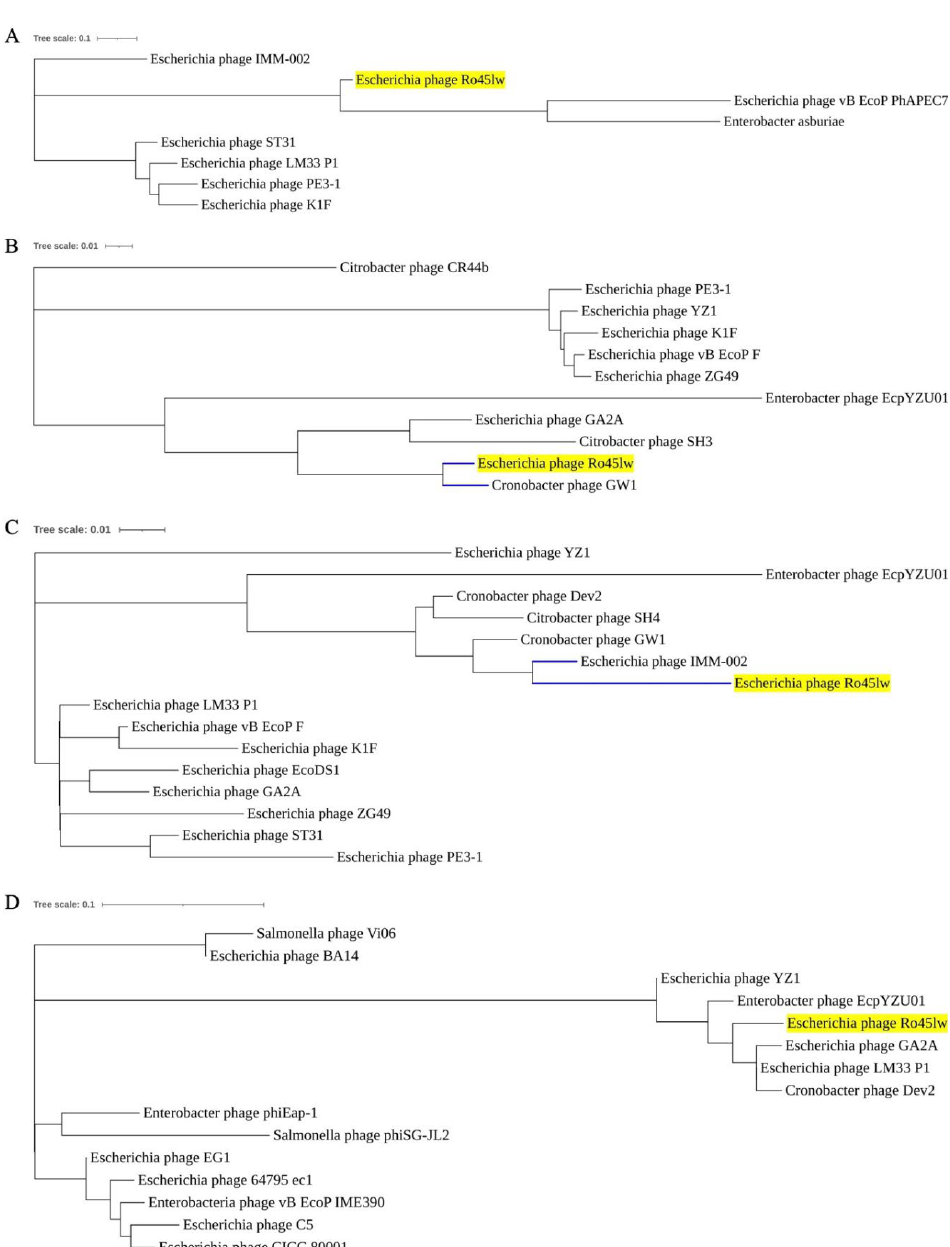
Figure 3. Phylogenetic tree of phage Ro45lw (with yellow highlight) and the close-related reference phages based on the Clustal Omega alignment of the amino acid sequences of putative tail fiber protein (ORF_44) ( A ), tail tubular protein B (ORF_37) ( B ), lysozyme (ORF_17) ( C ), and putative class II holin (ORF_45) ( D ). Blue lines are used to indicate the closest evolutionary relationship. The scale represents the homology percentage.